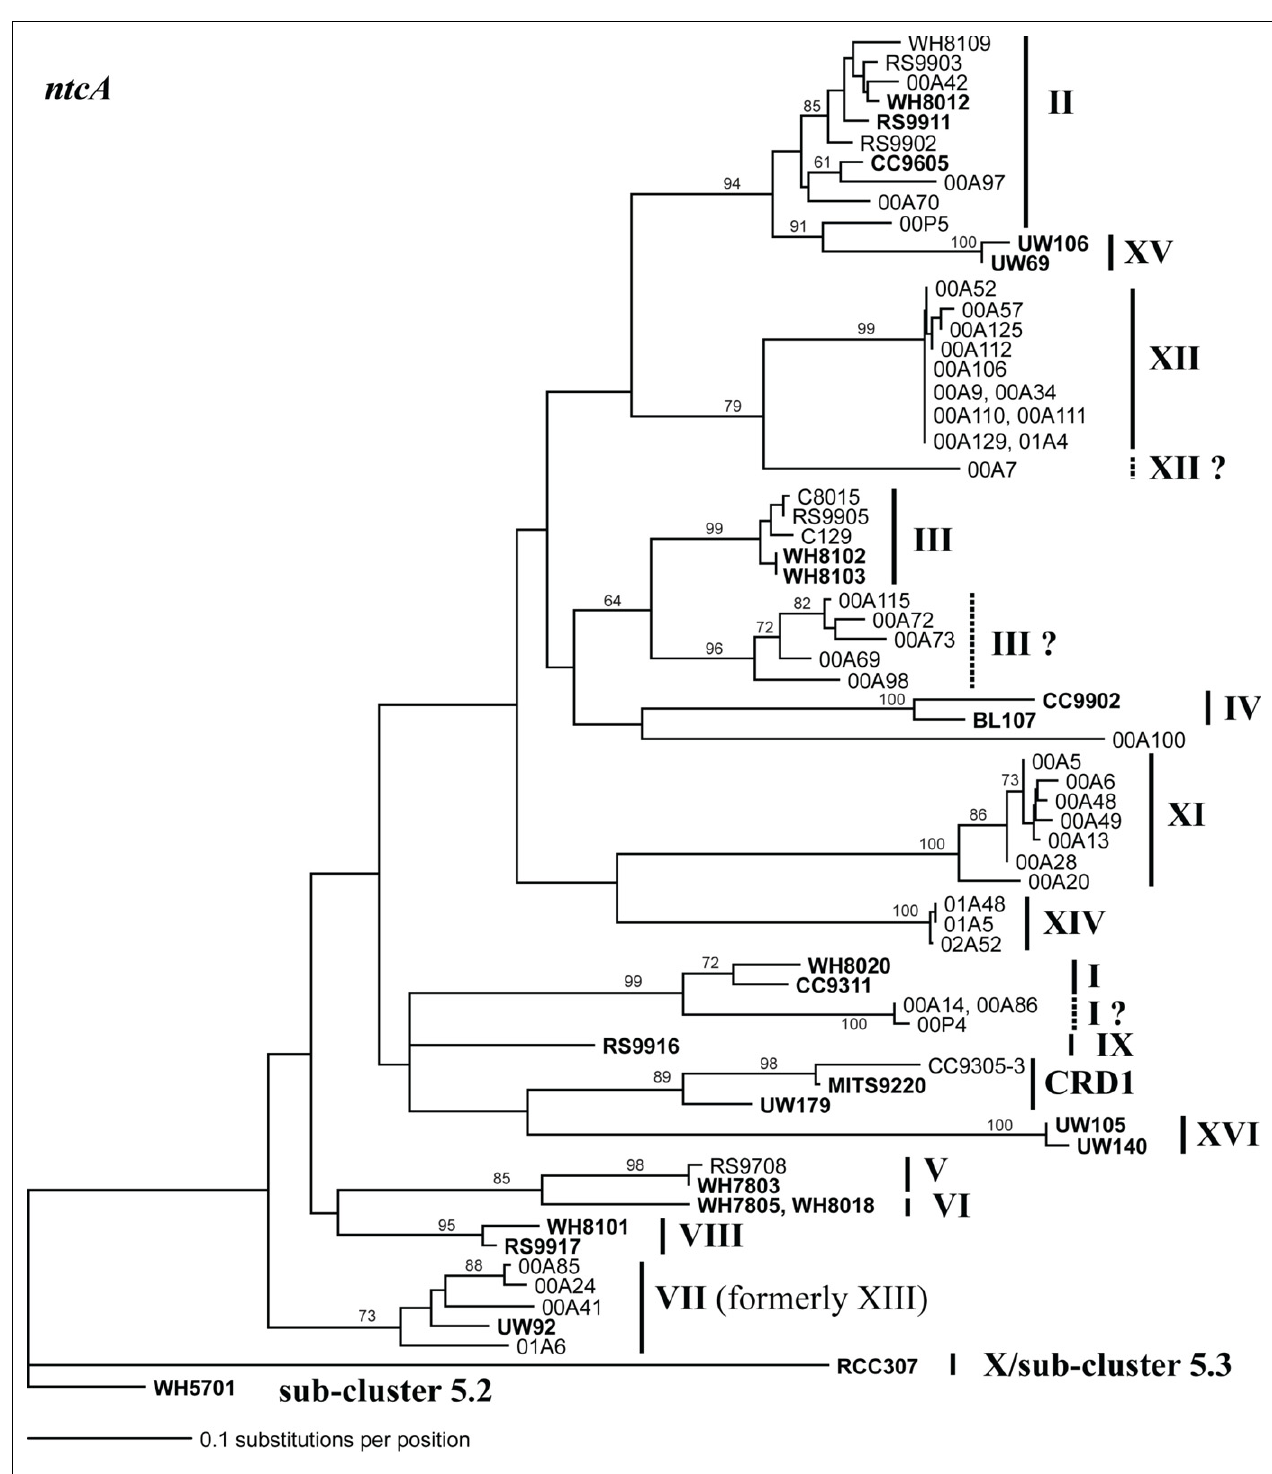
reclassified to cladeVII. Clades I, III, and XII contain groups of sequences that may warrant classification into new clades because they are as divergent from other sequences in their own clade as they are to other clades.These groups of sequences are labeled with a dashed line and a “?” following the clade name assigned by Penno et